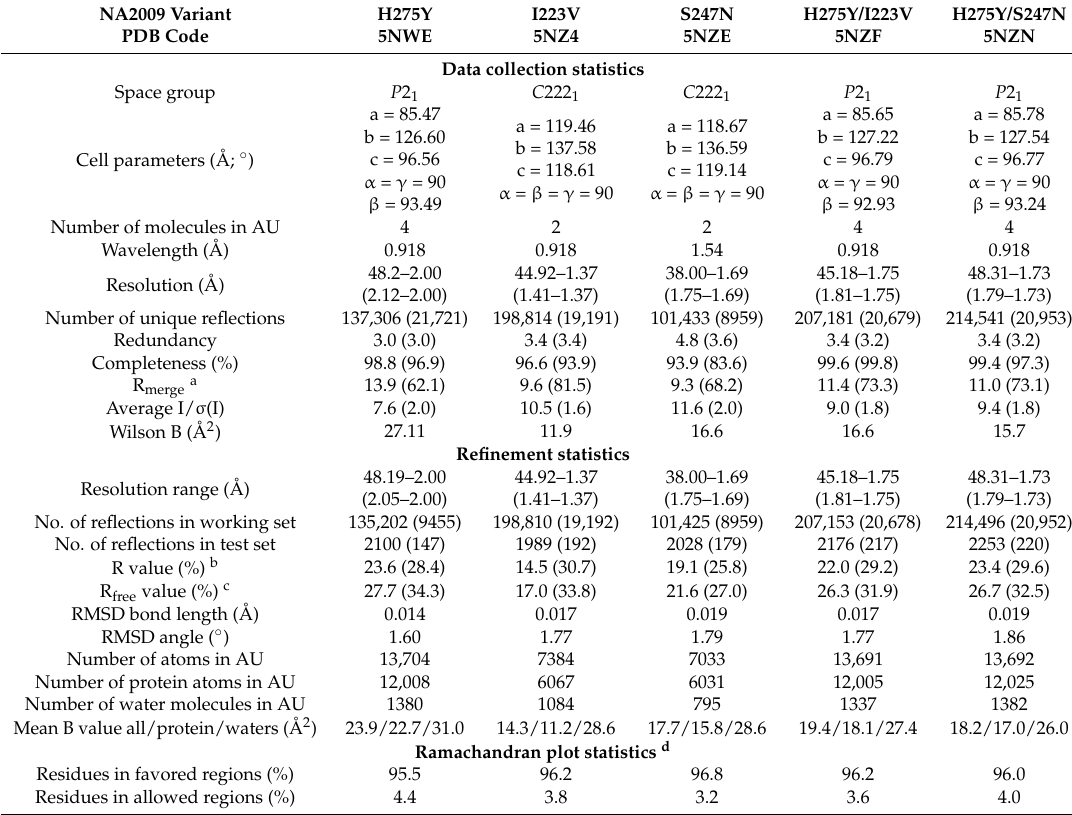
Table 1. Crystal data and diffraction data collection and refinement